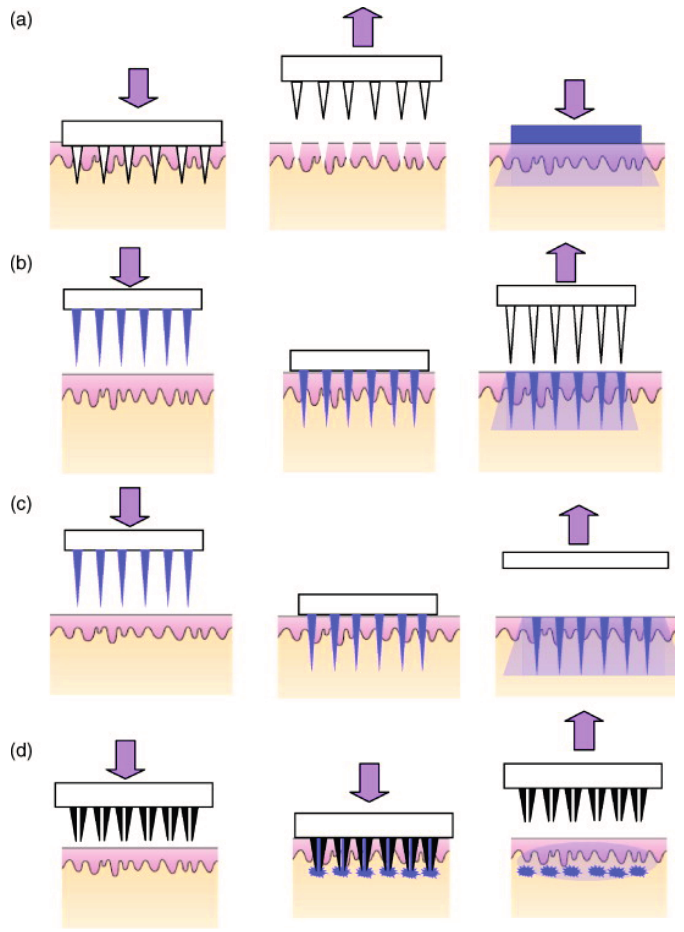
Figure 15. A schematic representation of four different MN application methods used to facilitate drug delivery transdermally. ( a ) Solid MNs for increasing the permeability of a drug formulation by creating micro-holes across the skin; ( b ) Coated MNs for rapid dissolution of the coated drug into the skin; ( c ) Dissolvable MNs for rapid or controlled release of the drug incorporated within the microneedles; ( d ) Hollow MNs used to puncture the skin and enable release of a liquid drug following active infusion or diffusion of the formulation through the needle bores. (Reprinted from [11] with permission. Copyright 2008